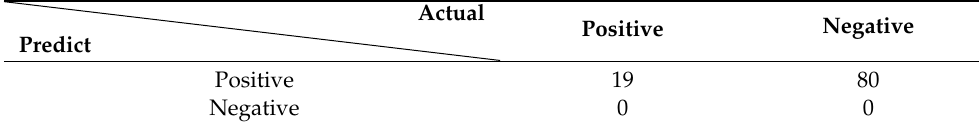
Table 4. The confusion matrix obtained according to STA/LTA pickup results.